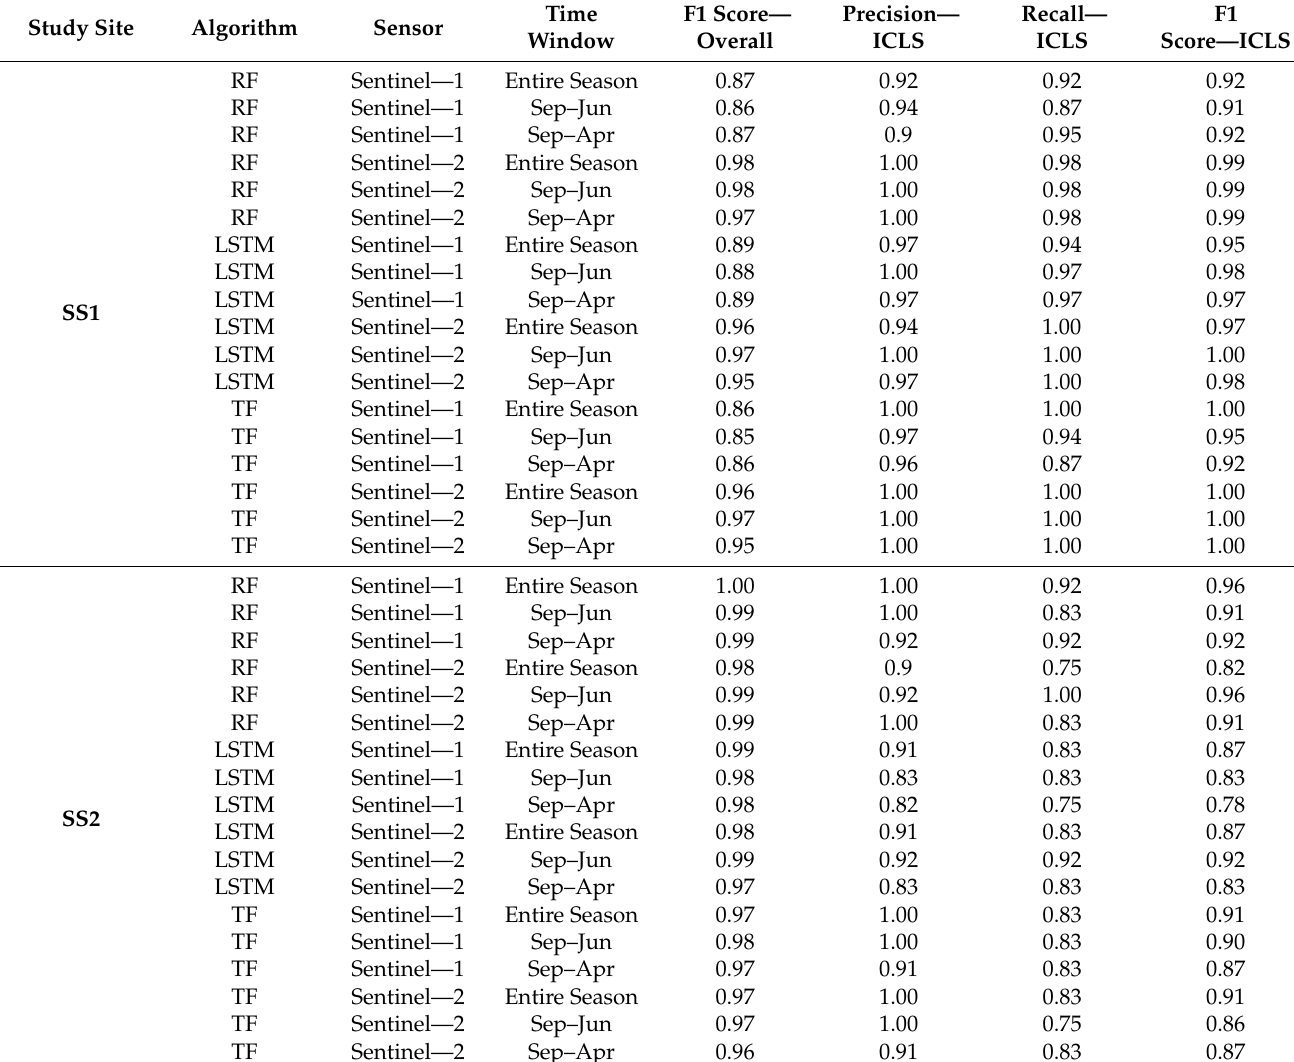
Table 2. Overall and ICLS-focused accuracy values for each study area, sensor, classifier, and time